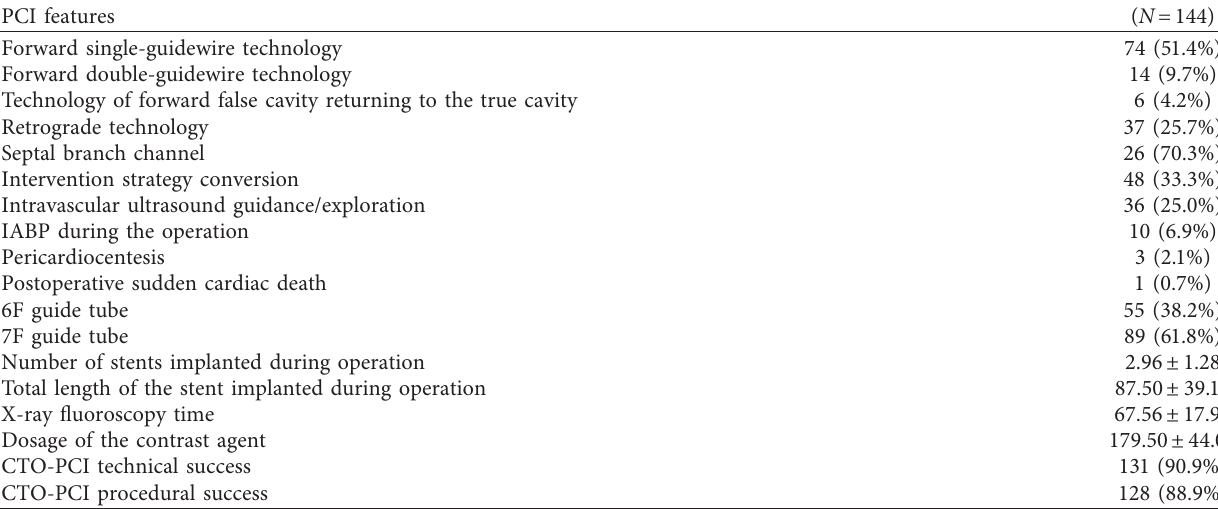
Table 5: PCI features of the study population.